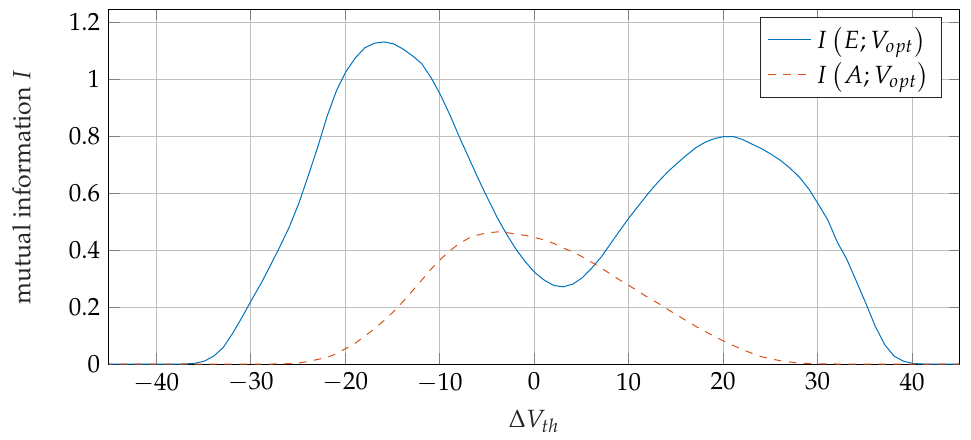
Figure 8. Mutual information between number of errors or the binary variable A and optimal threshold voltage for reference r 7 over read voltage.